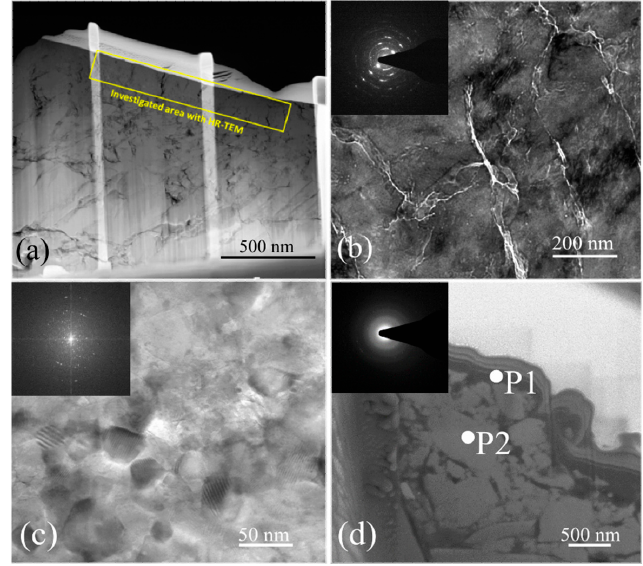
Figure 2. Microstructural investigation of deformed cohesive Carrara marble samples. ( a ) Rock